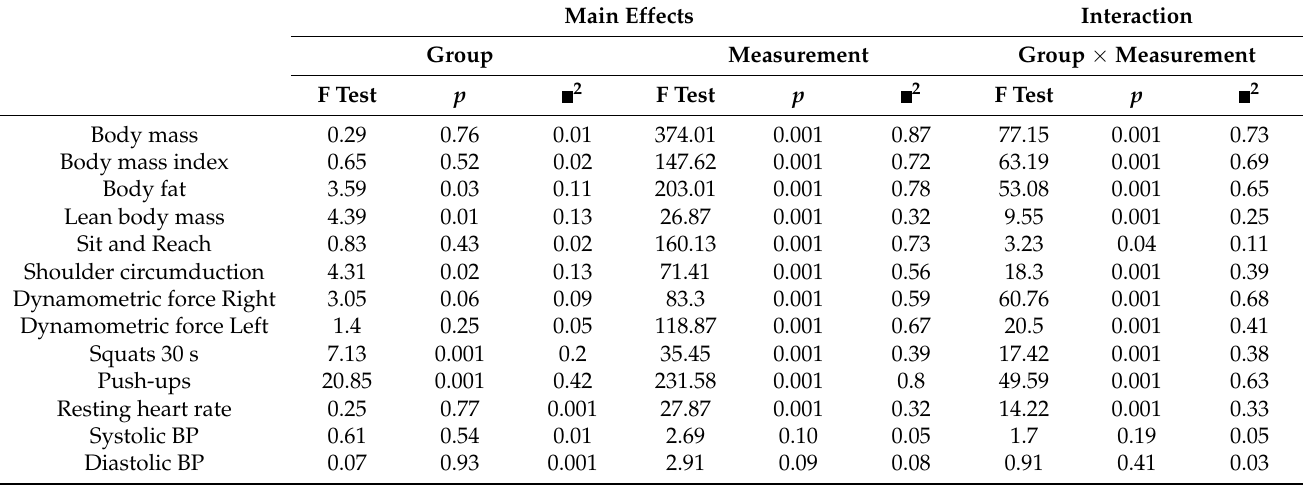
Table 2. Results of the factorial analysis of variance for repeated measurements, with “Group” (endurance-training, resistance training, and control), and Measurement (Pre- and Post-measurement) as main factors, and Group × Measurement interaction factor ( p —level of significance, η 2 —effect size).